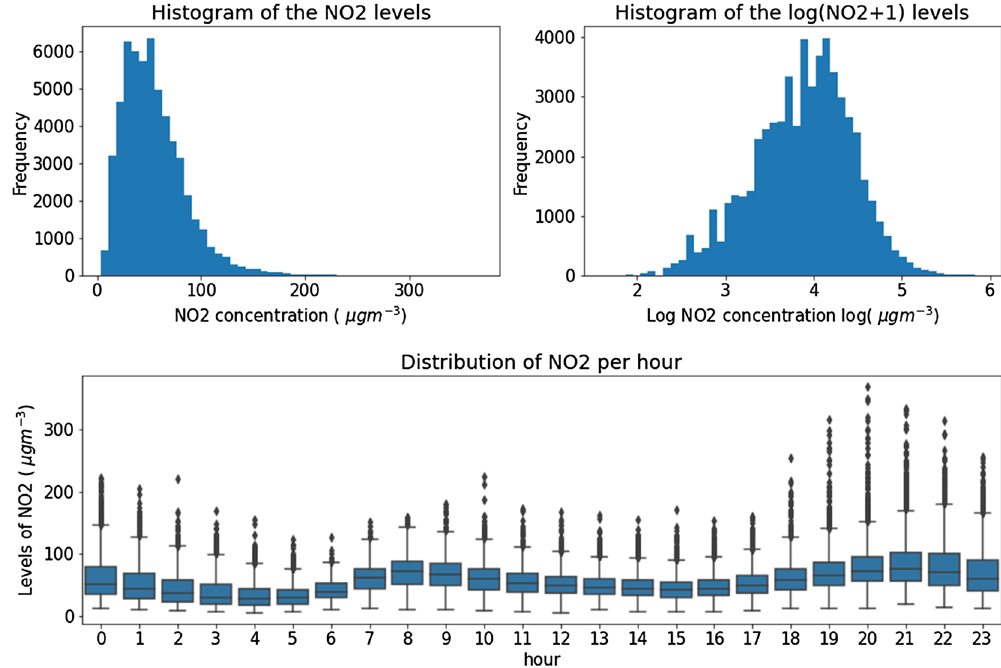
Figure 1. Distribution of logarithmic NO 2 and distribution of NO 2 per